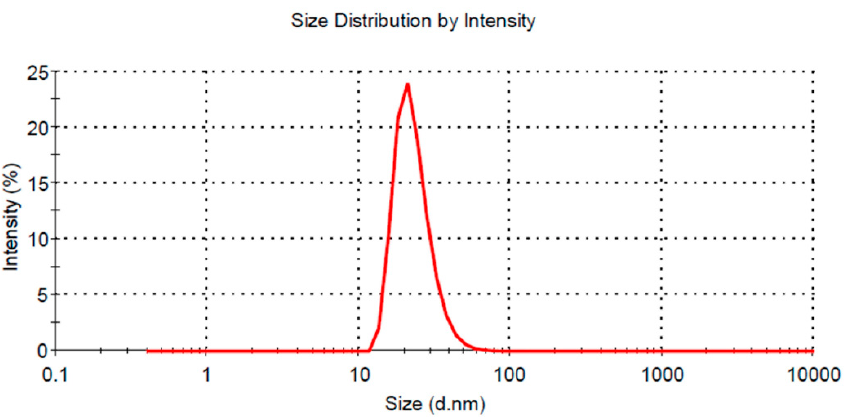
Figure 5. Droplet size distribution of the optimized liquid SNEDDS formulation.